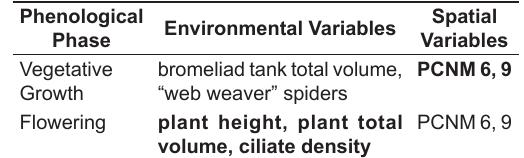
Table 3. Environmental and spatial variables selected